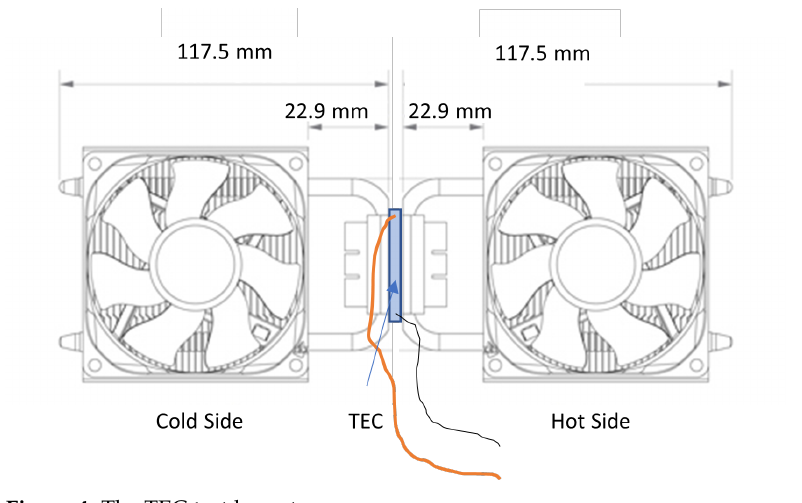
Figure 4. The TEC test